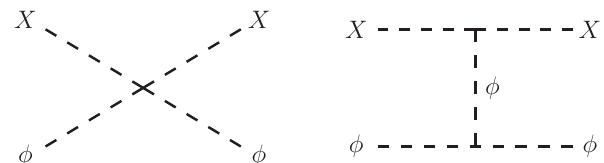
Figure 4: Interactions of the DM with the scalar driving the PT, φ , which can lead to kinetic equilibrium being re-established following the